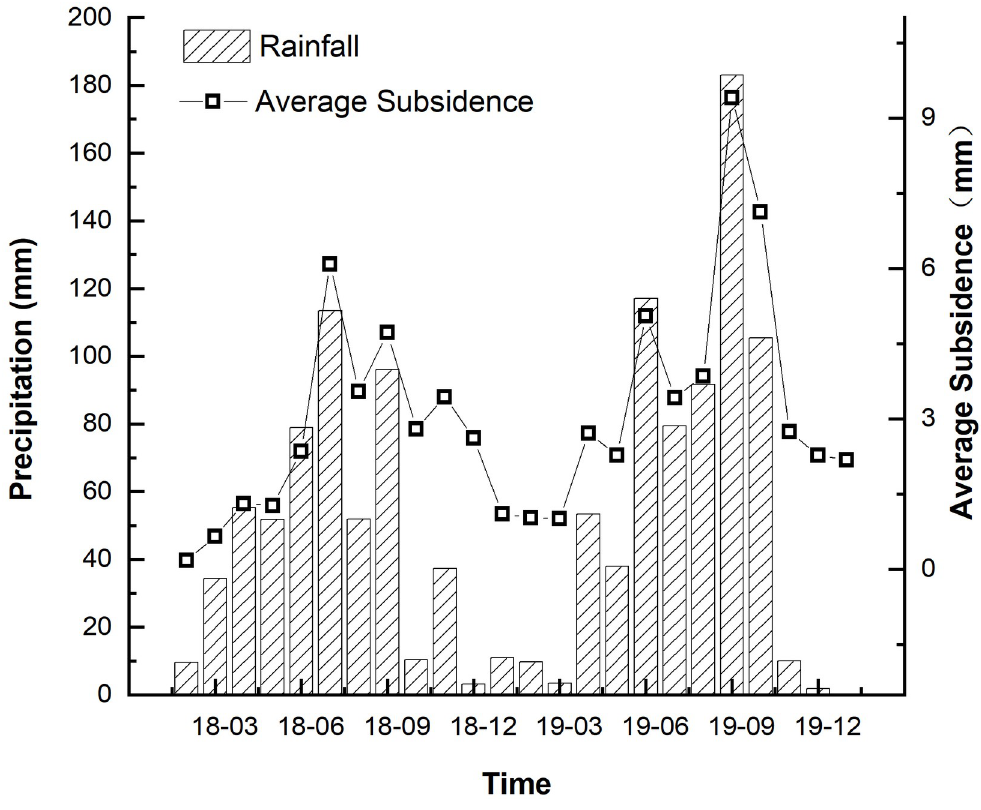
Fig 9. Subsidence in the target area vs. monthly erosive